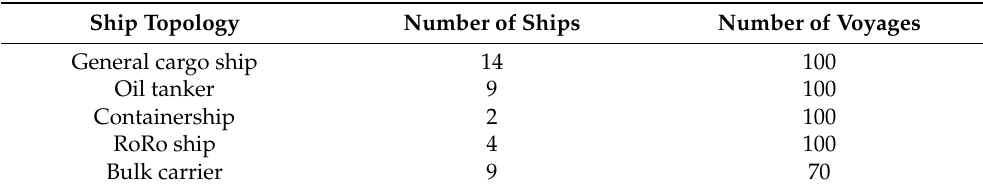
Table 4. Ship topologies selected to generate the training set for the DNN approach and the associated number of ships and